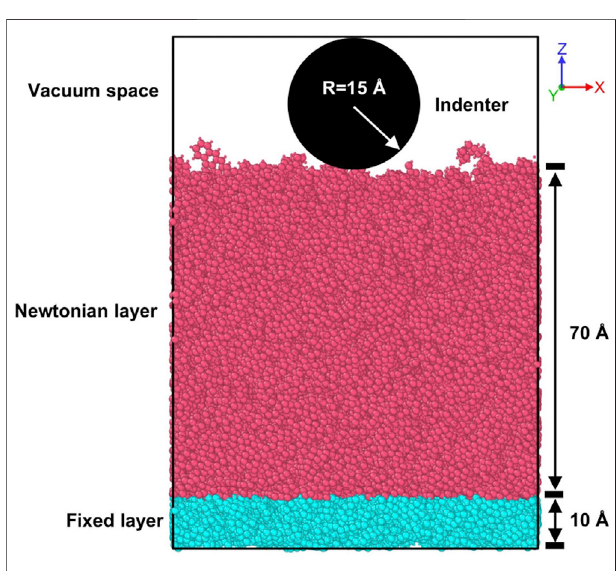
FIGURE2| Layeredstructureofthevitrinitesubstrate,withthespherical ghost indenter located above.